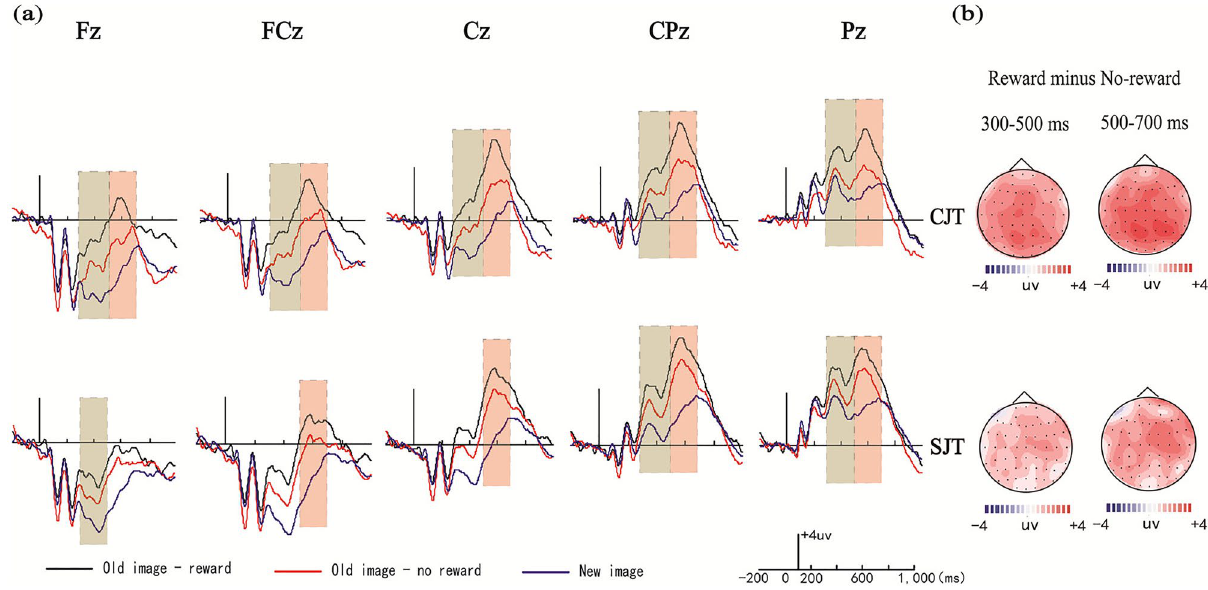
Figure 4. Amplitude distribution and topographic maps of ERPs in the different conditions in the object test phase. ( a ) Amplitudes of the old-rewarded images, the old-unrewarded images and the new images were compared in the congruity-judgment and size-judgment tasks. ( b ) Topographic maps of reward-effect ERPs in the two encoding conditions. Note, CJT, congruity-judgment task; SJT, size-judgment